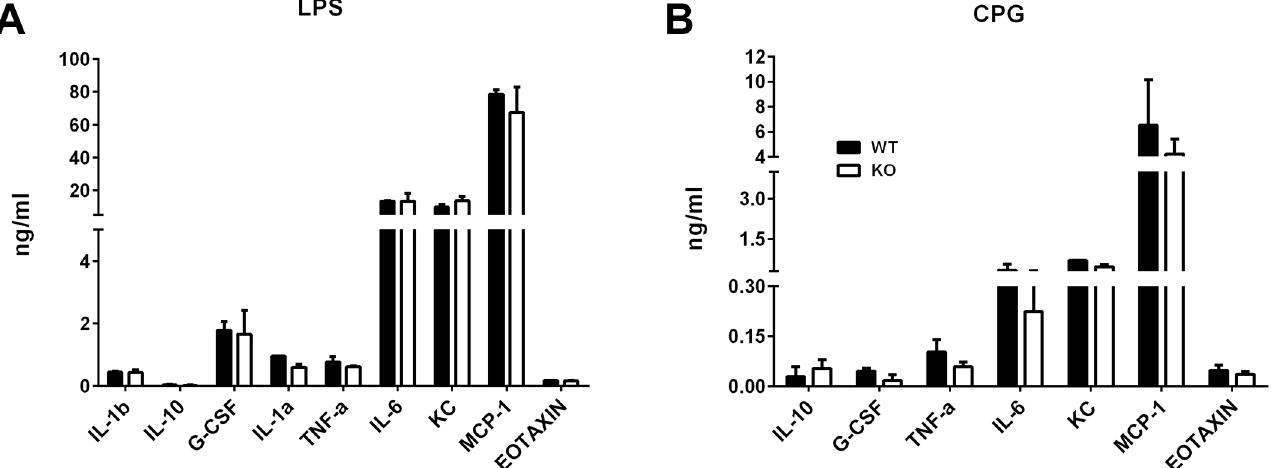
Fig 5. Minute differences seen in the profiles of cytokines/chemokines released by peritoneal macrophages of the Lrrk2 (-/-) ( “ KO ” ) and their WT controls, cultured with LPS (0.5 μ g/ml) or CpG (40 μ g/ml) for 48 hrs. The levels of the released products were measured by a bead-based multi-plex screening assay. The assay measured secretion of 14 analytes, as detailed in the Materials and Methods section, but molecules with undetectable levels were not included in the figure. The figures show combined data collected in two individual experiments and combined for